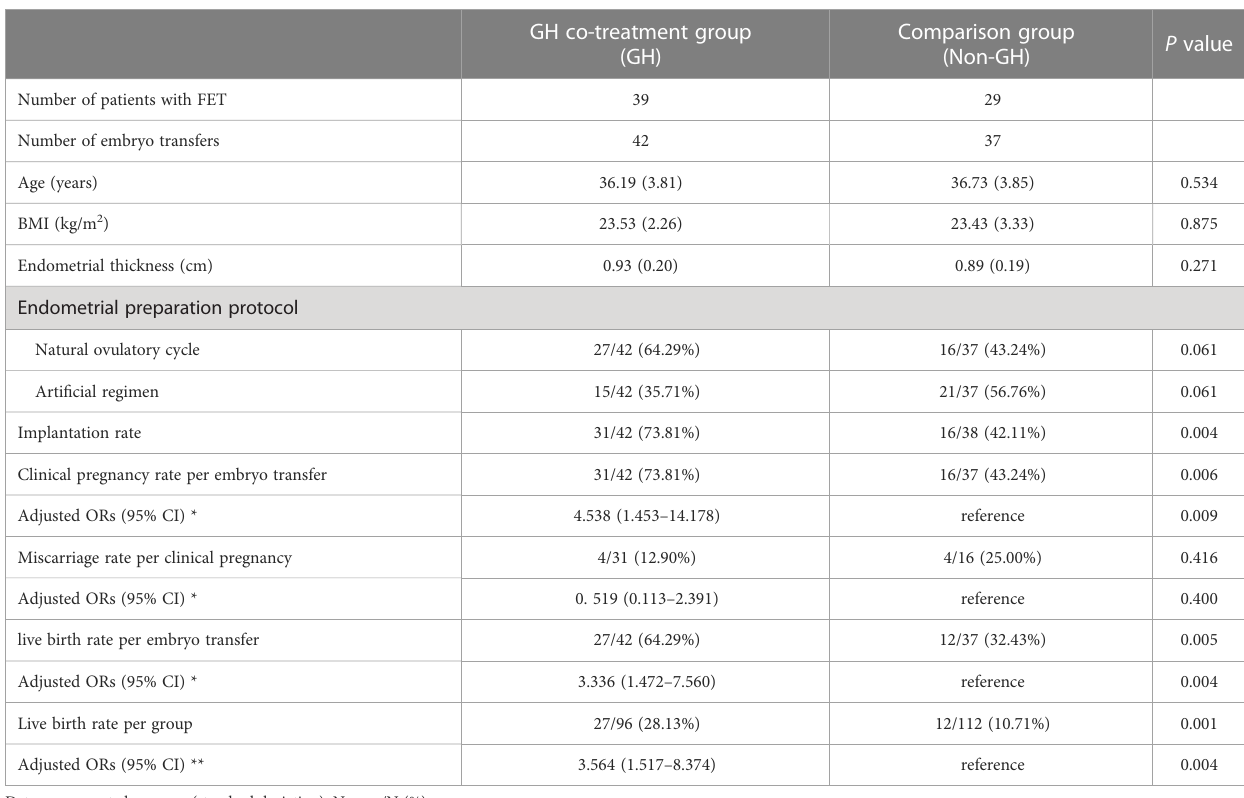
TABLE 4 Comparison of pregnancy